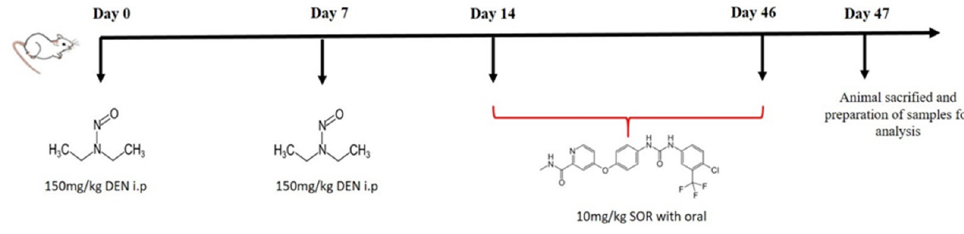
Figure 7. Treatment schedule of the experiment.